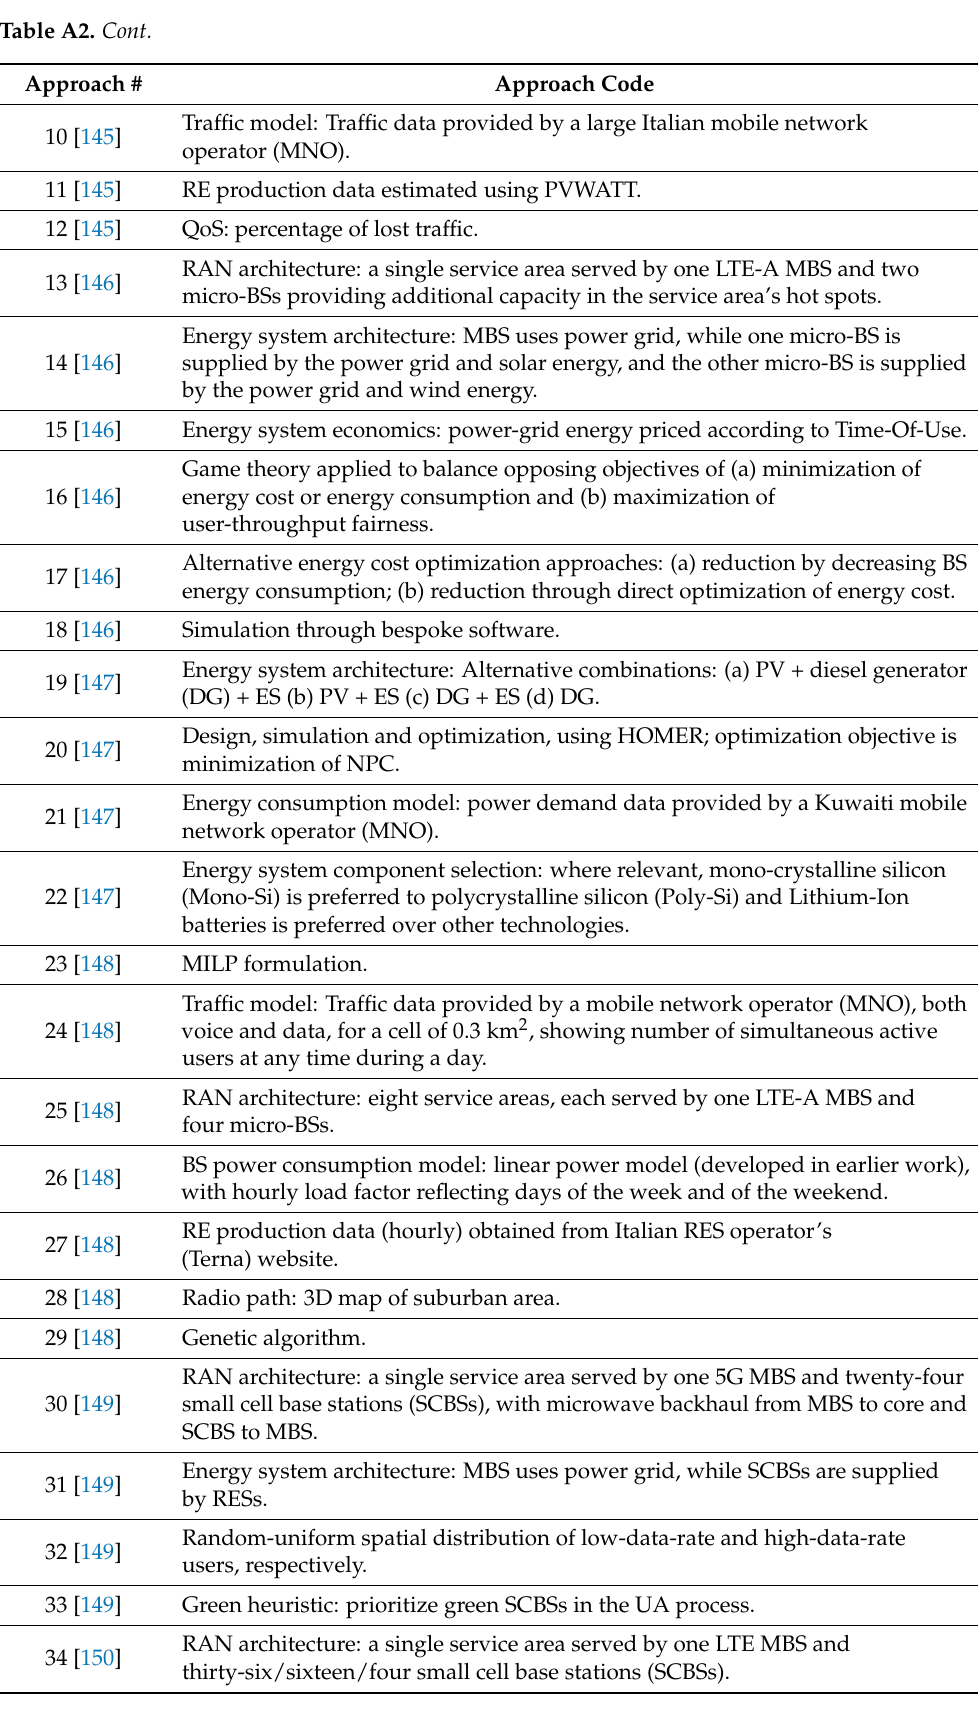
Table A2. Cont. Approach